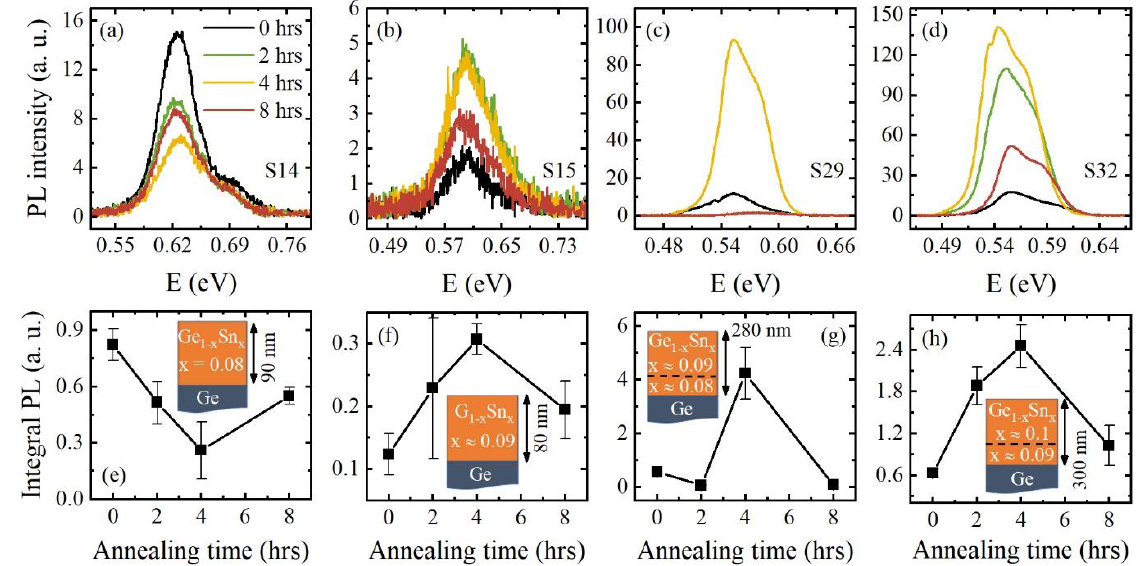
Figure 4. ( a – d ) PL at 10 K for four GeSn samples: S15 and S29 with about 9% Sn, S14 at 8% Sn, and S32 with about 10% Sn, and the corresponding ( e – h ) integrated PL. Measurements are for 0, 2, 4, and 8 hours annealing. Insets indicate the GeSn structure.